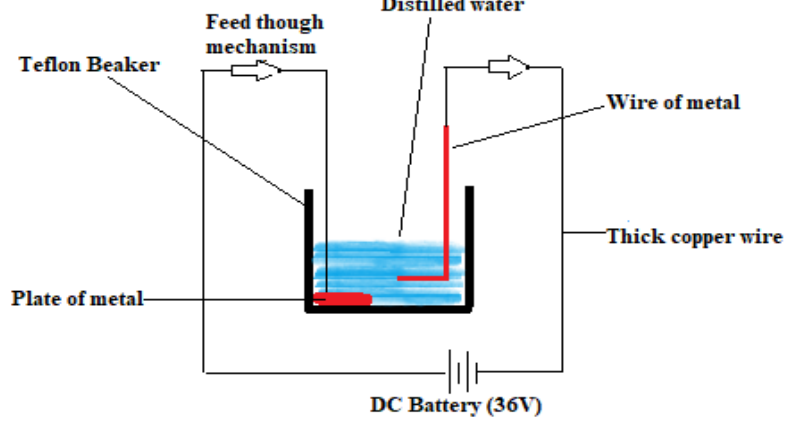
Figure 1: A schematic diagram for Ag nanoparticles prepared by (EEW) set